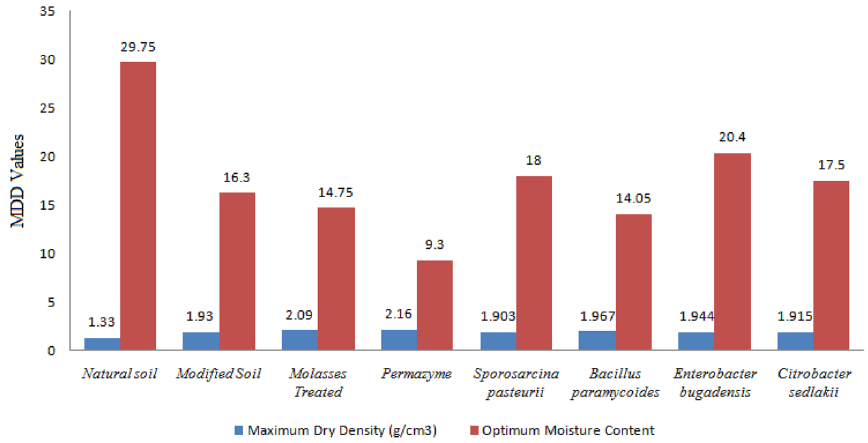
Fig. 5 Compaction characteristics of treated and 7 days cured soil